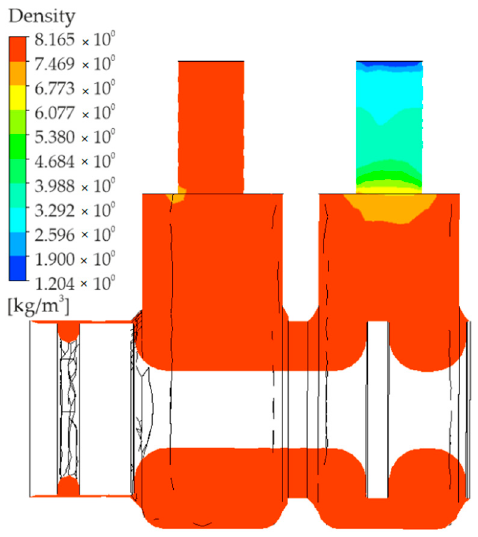
Figure 8. Distribution of density.